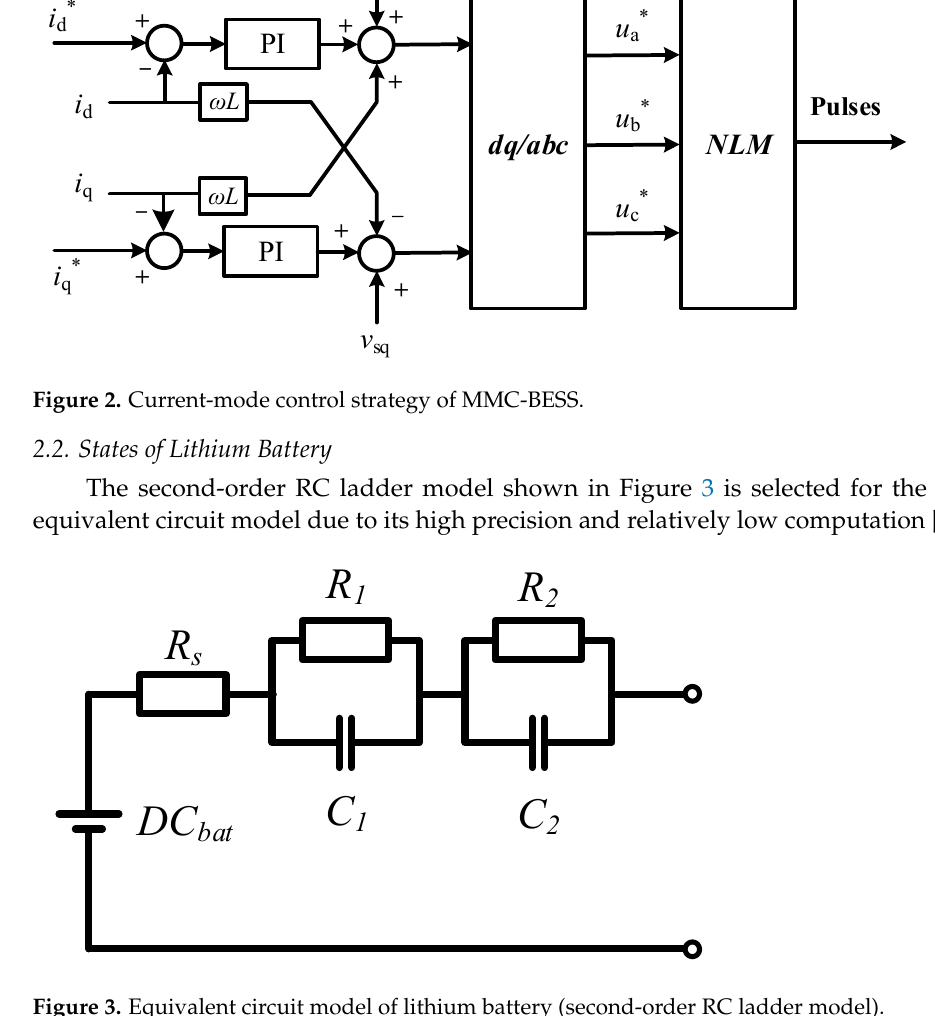
Figure 3. Equivalent circuit model of lithium battery (second-order RC ladder model).